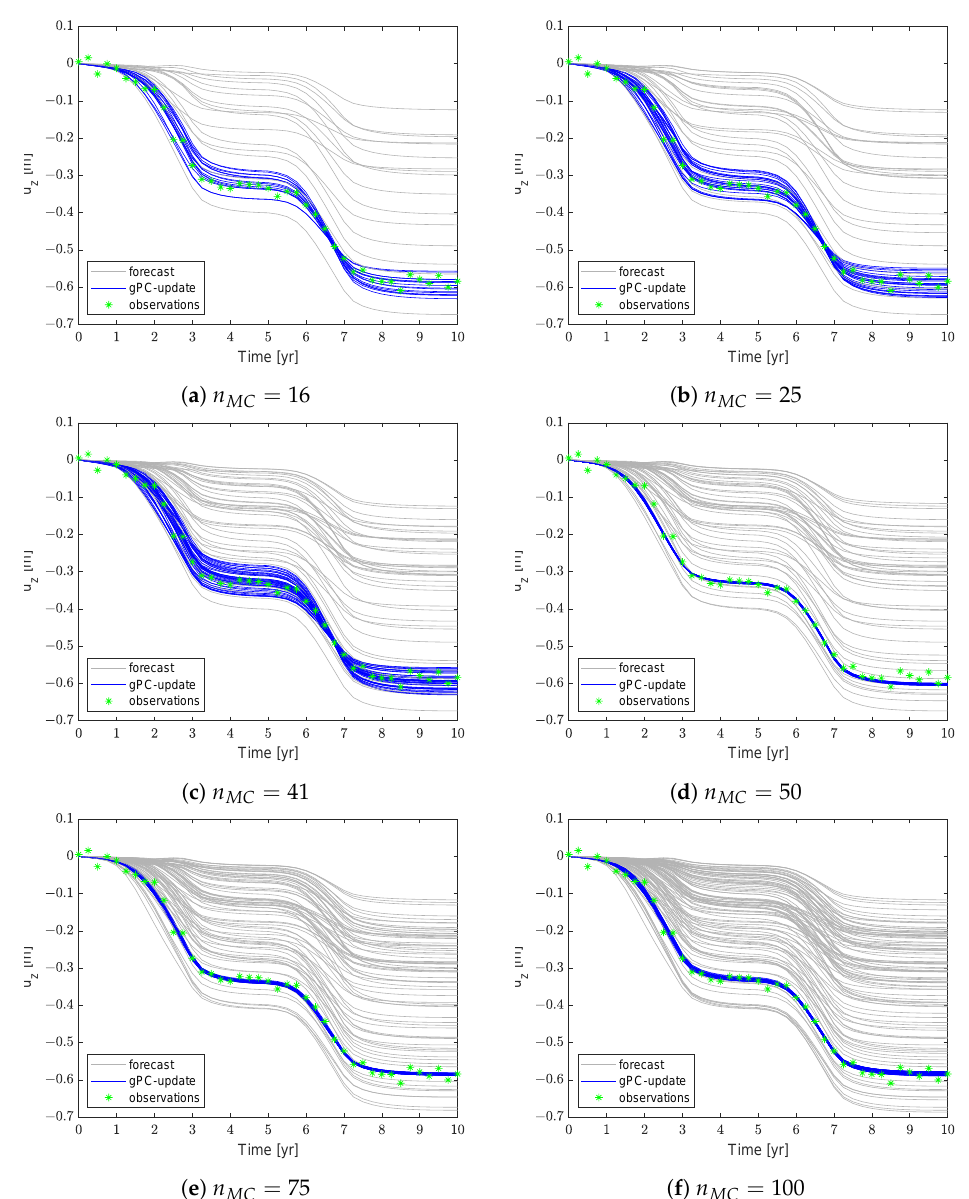
Figure 6. The same as Figure 5 with the forecast ensembles, in grey, obtained through the gPC